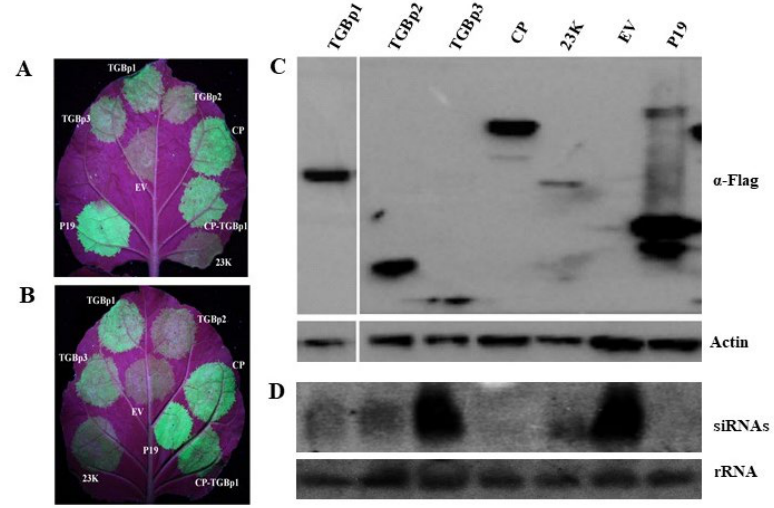
Figure 7. Identification of local RNA silencing suppression activity of CYVCV proteins. ( A , B ) Leaves of wild-type N. benthamiana plants were coinfiltrated with recombinant plasmids and visualized under long-wavelength UV light at 4 dpi. Leaf patches coinfiltrated with tomato bushy stunt virus (TBSV) P19 and 35S-GFP or an empty vector (EV) and 35S-GFP were used as positive or negative controls, respectively. ( C , D ) Western and Northern blot analyses of GFP and gfp-siRNA in infiltrated blotches of N. benthamiana leaves, respectively. Actin and rRNA from the same N. benthamiana samples were used as loading controls.